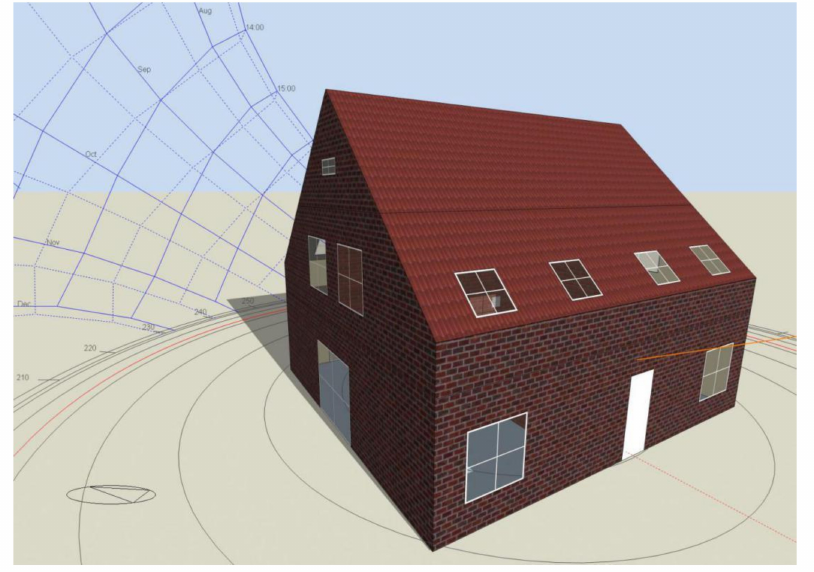
Figure 3. Visualization of the single-family house model made in DesignBuilder